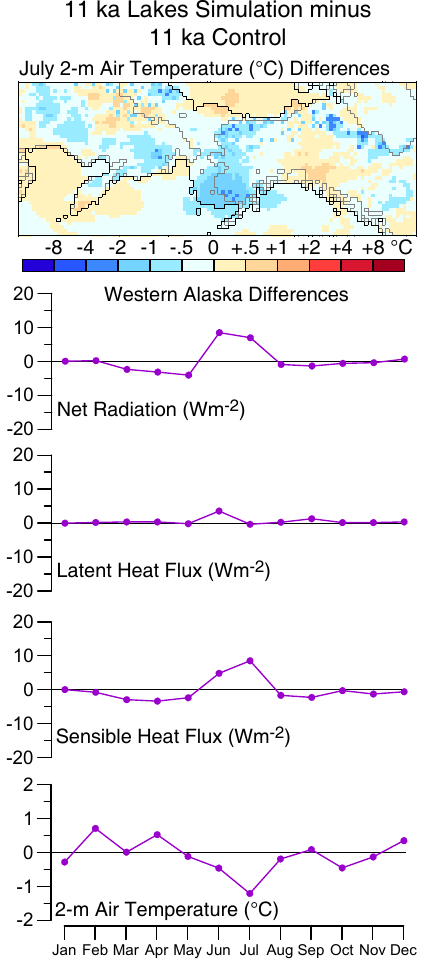
Figure 8. Results of 11ka Lakes experiment. Top panel shows July 2m air temperature differences ( 11ka Lakes minus 11ka Control ). Lower panels show mean monthly differences for energy fluxes and temperature for RegCM grid cells in western Alaska (170–150 ◦ W longitude), where cooling is most pronounced. Ice-sheet and coastal outlines as in Fig.